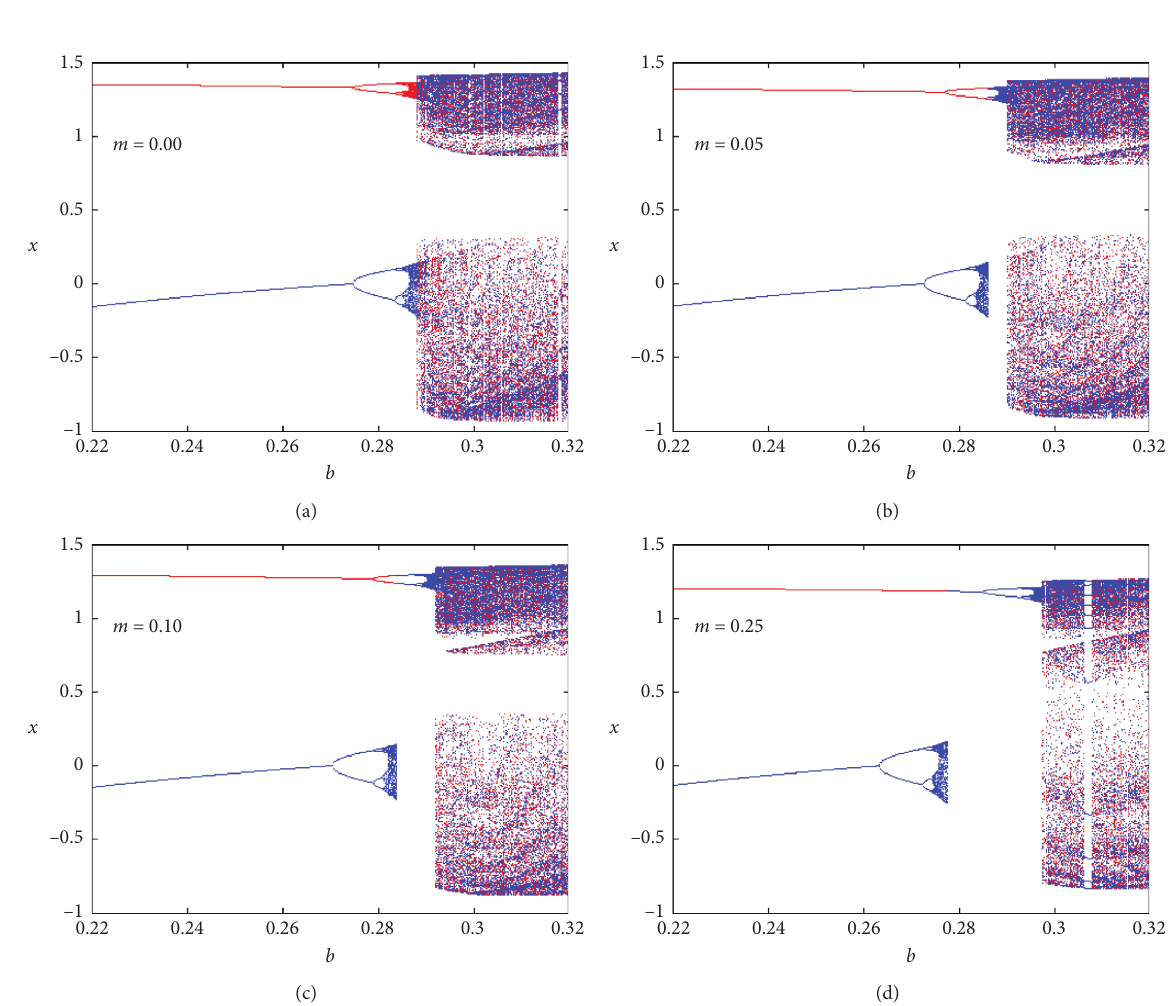
Figure 1: Bifurcation diagrams as a function of the parameter b showing destruction of the symmetry of the system for some values of m : (a) the symmetric system for m � 0 . 00; (b–d) destruction of the system’s symmetry for m � 0 . 05 ,m � 0 . 10, and m � 0 . 25, respectively. The initial conditions are ( x ( 0 ) , y ( 0 ) , z ( 0 )) � ( 0 . 25 , 0 , 0 ) and (− 0 . 25 , 0 , 0 ) for the traces in red and blue,